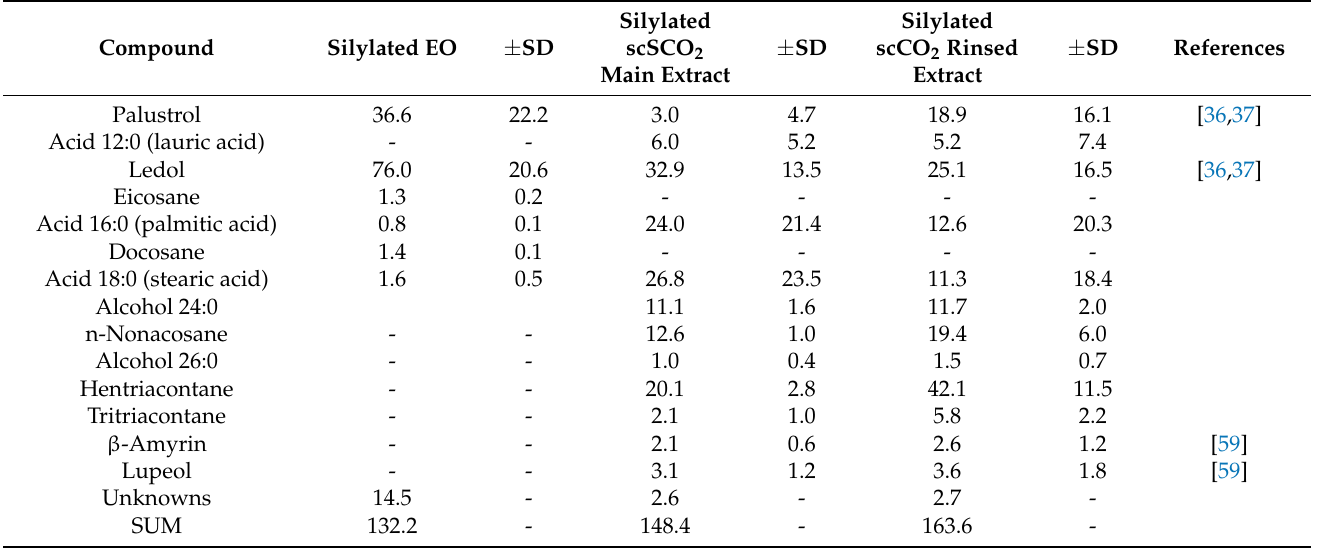
Table 7. The chemical composition (mg/g) of the silylated marsh Labrador tea EO ( 2 ) and scCO 2 extracts ( 5 ).